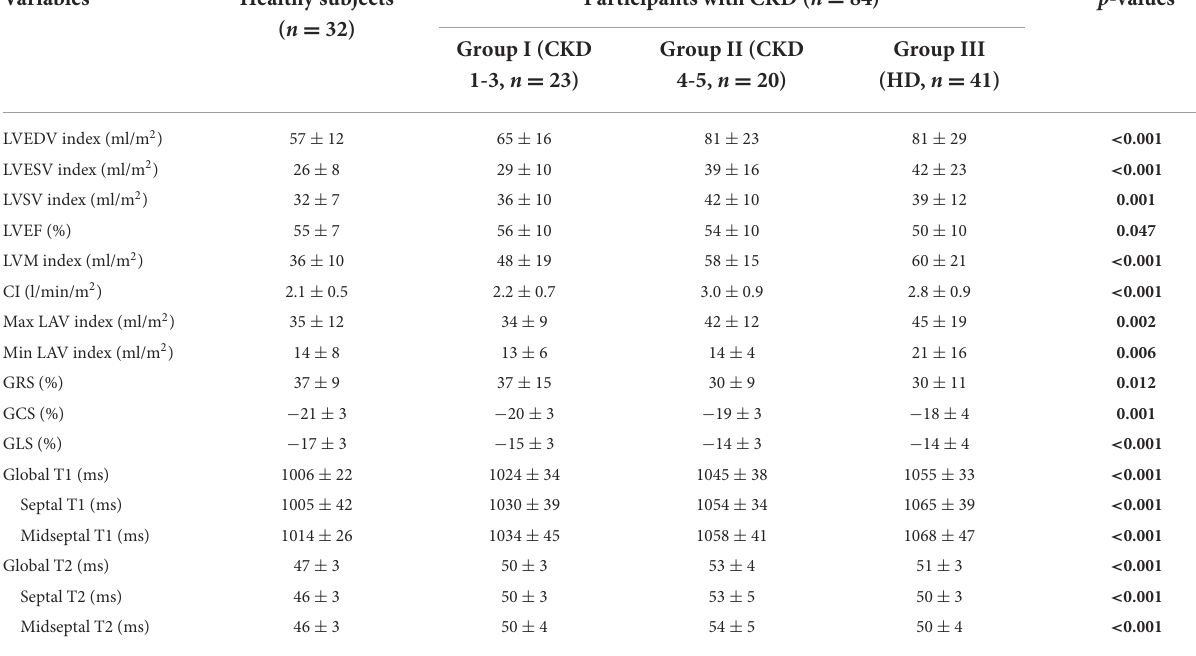
TABLE 2 MRI characteristics of the study